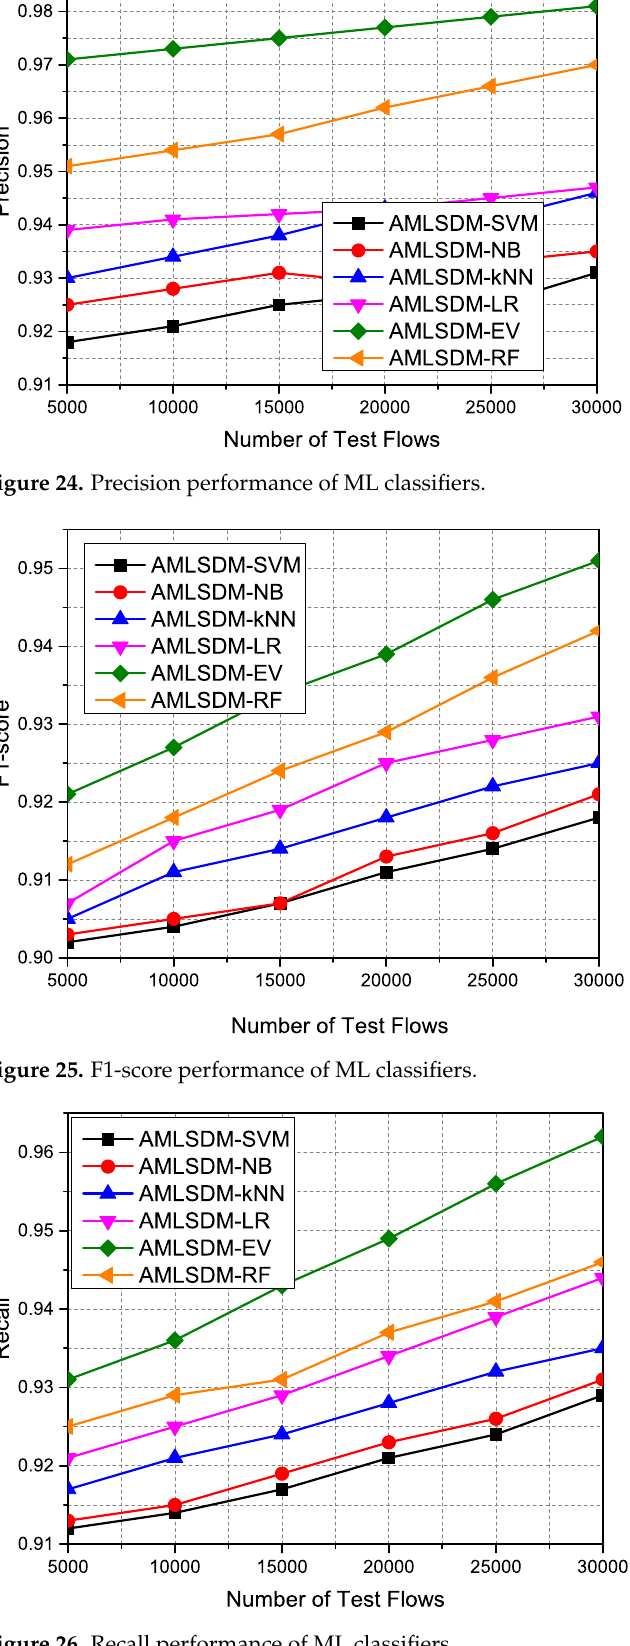
Figure 26. Recall performance of ML